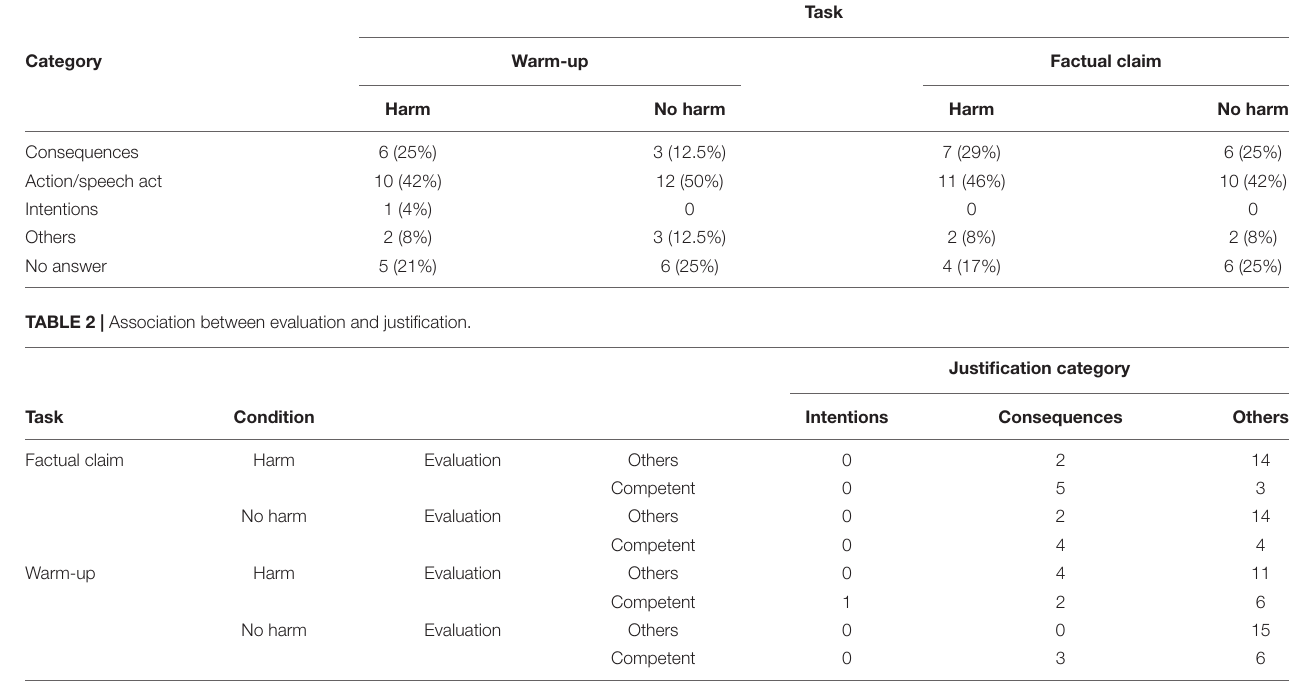
FIGURE 1 | Mean score of children’s evaluation (from 0 = very good to 4 = very bad). Error bars depict standard error of the mean. TABLE 1 | Frequencies (percentage) of justifications.